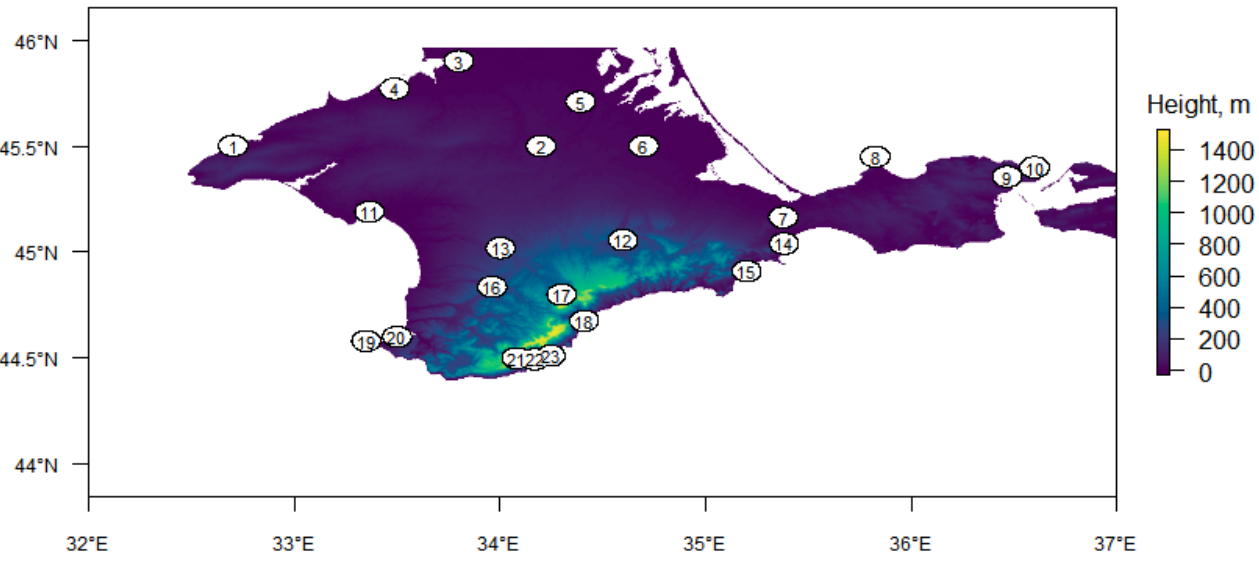
Figure 1. Current network of meteorological stations in the Crimean region. Numbering of stations corresponds to the serial number in Table 1.